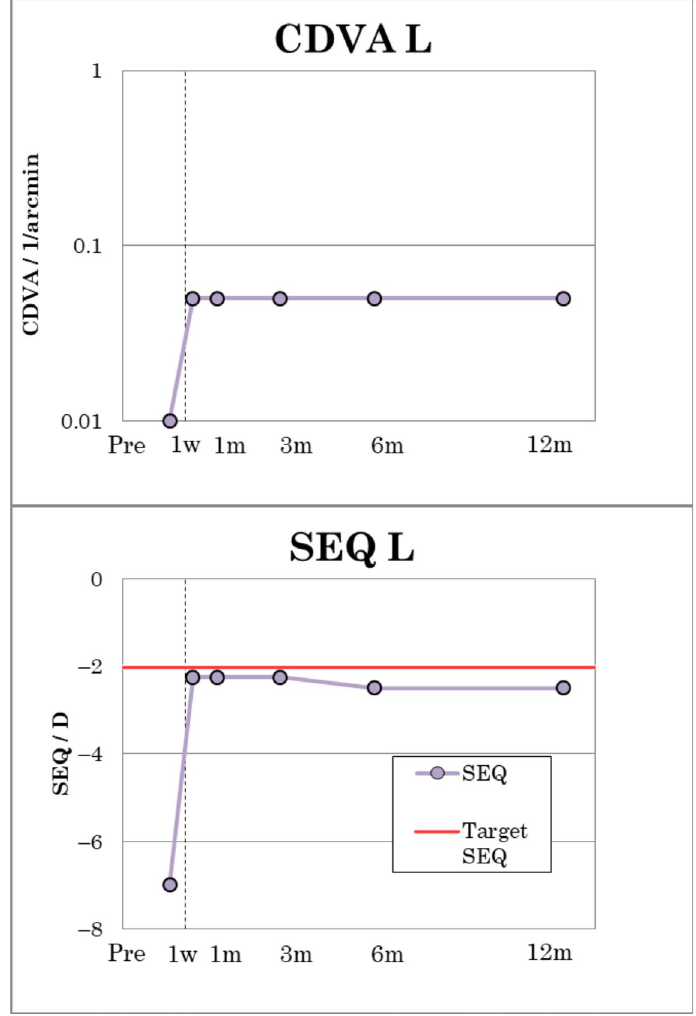
Figure 4. Visual outcomes of patient No. 1. Table 3. Summary of visual outcomes of patient